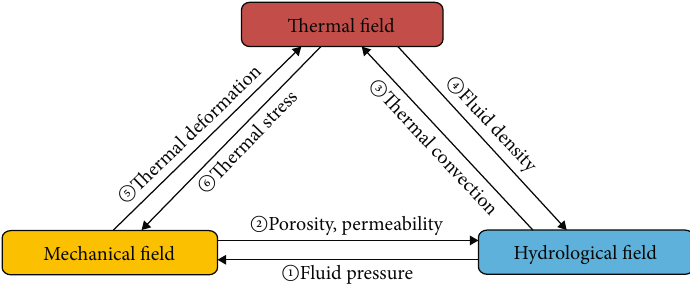
Figure 1: THM coupling